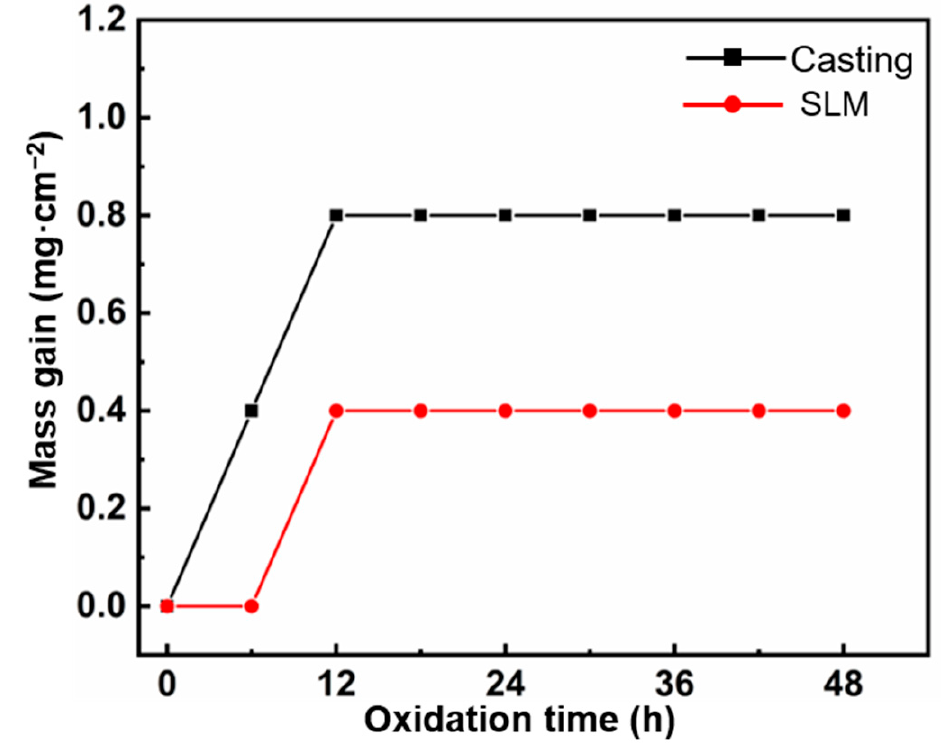
Figure 7. Recorded mass gain as a function of time during isothermal oxidation.